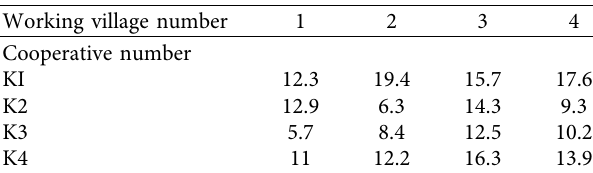
Table 5: Distance table of cooperatives and operating points.